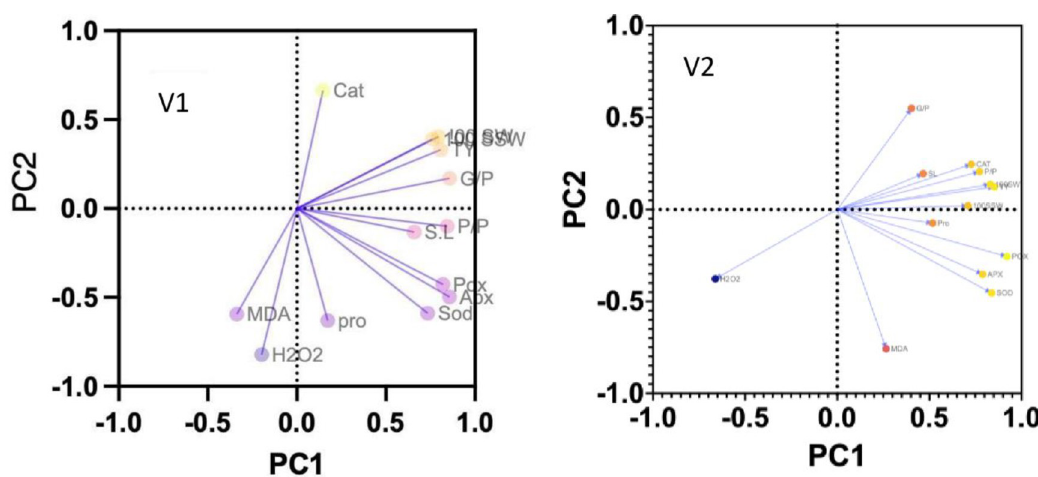
Fig 3. Biplot of PCA (principal component analysis) expressing different levels and relationship between enzyme productions, growth and yield parameter induction by drought tolerant strains in both varieties of Vigna radiata under water stress conditions. V1-AZRI 2006; V2-NM